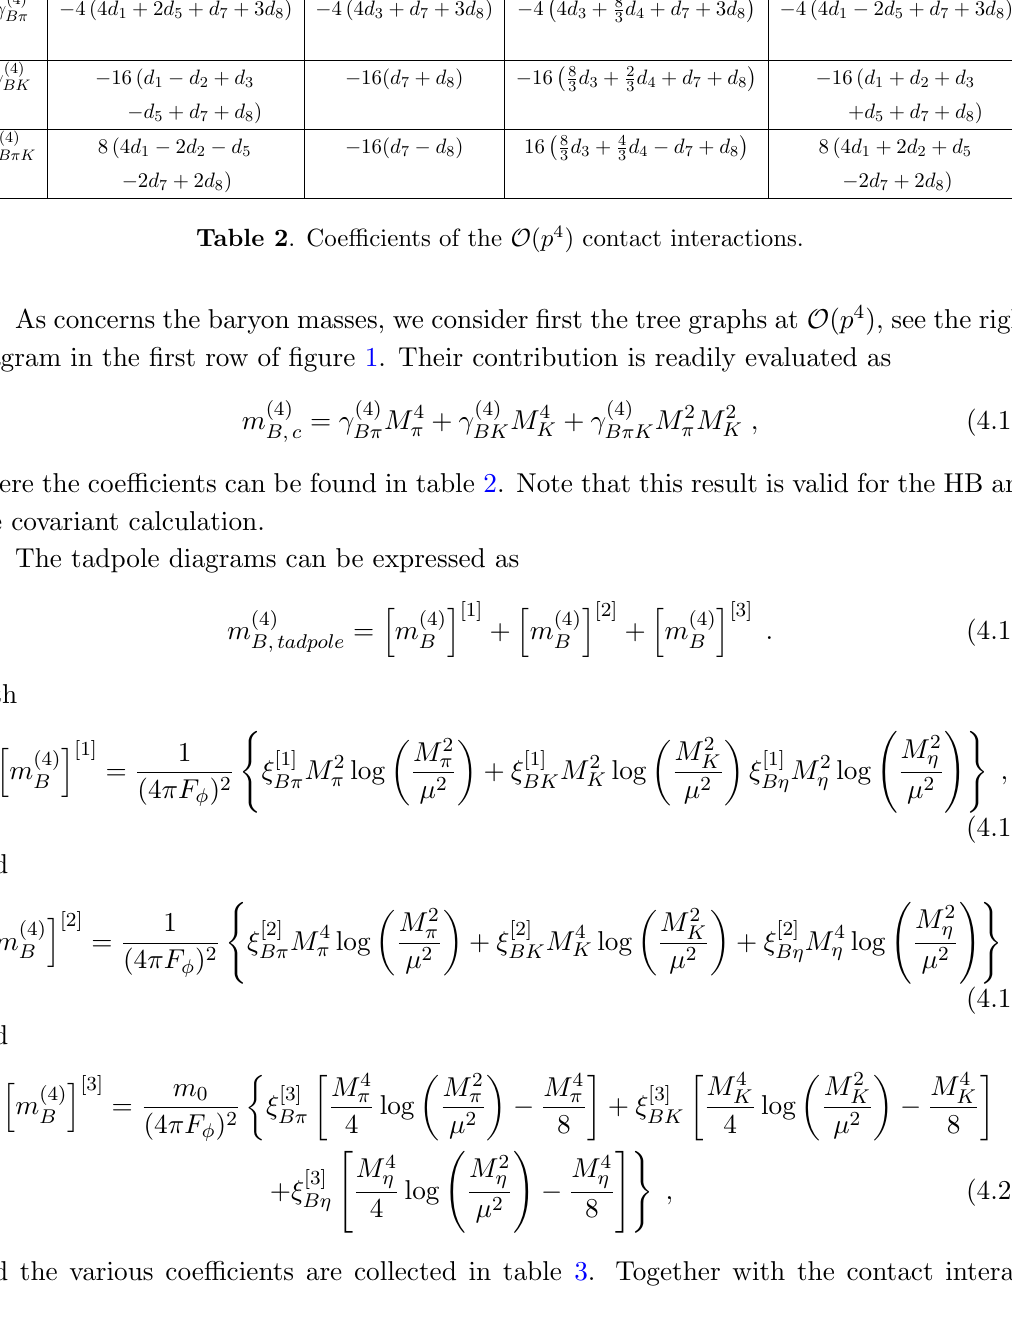
Table 1 . Coe(cid:14)cients of the O ( p 3 ) self-energy diagrams with the decuplet-baryon propagator. N